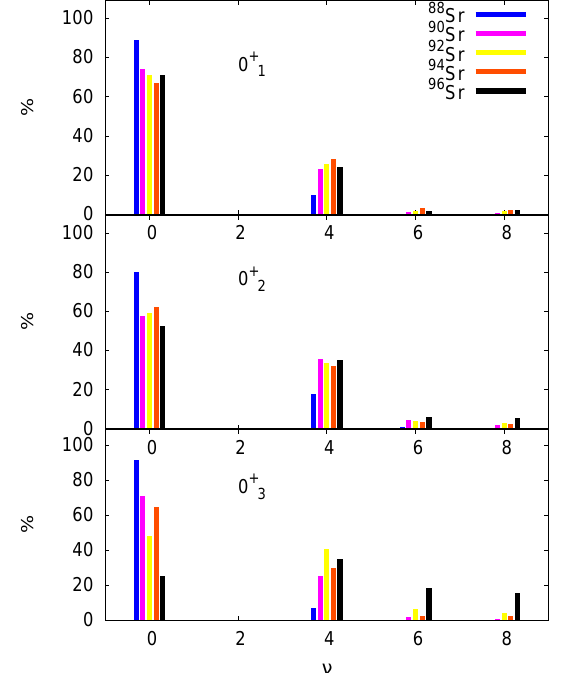
Figure 10. Seniority composition of the 0 + states in Sr